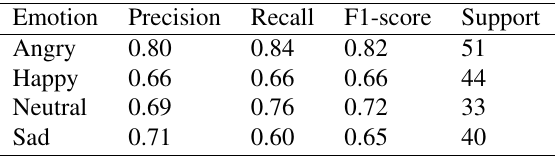
Table 2. Evaluation metrics for emotion recognition Emotion Precision Recall F1-score Support